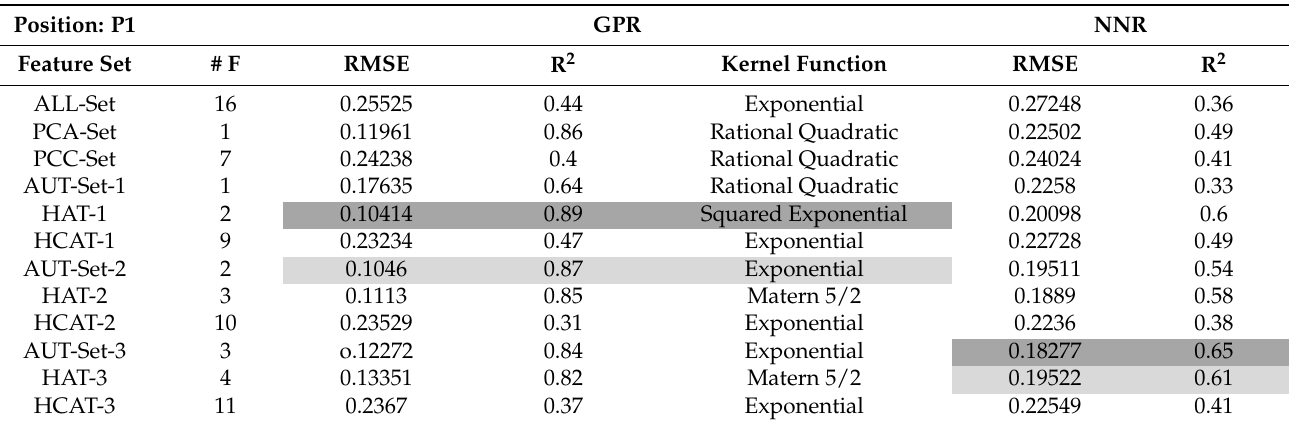
Table 10. SWH_KU_CAL prediction performance using GPR and NNR trained by various feature combinations for Position P1; ‘#’ denotes the number of